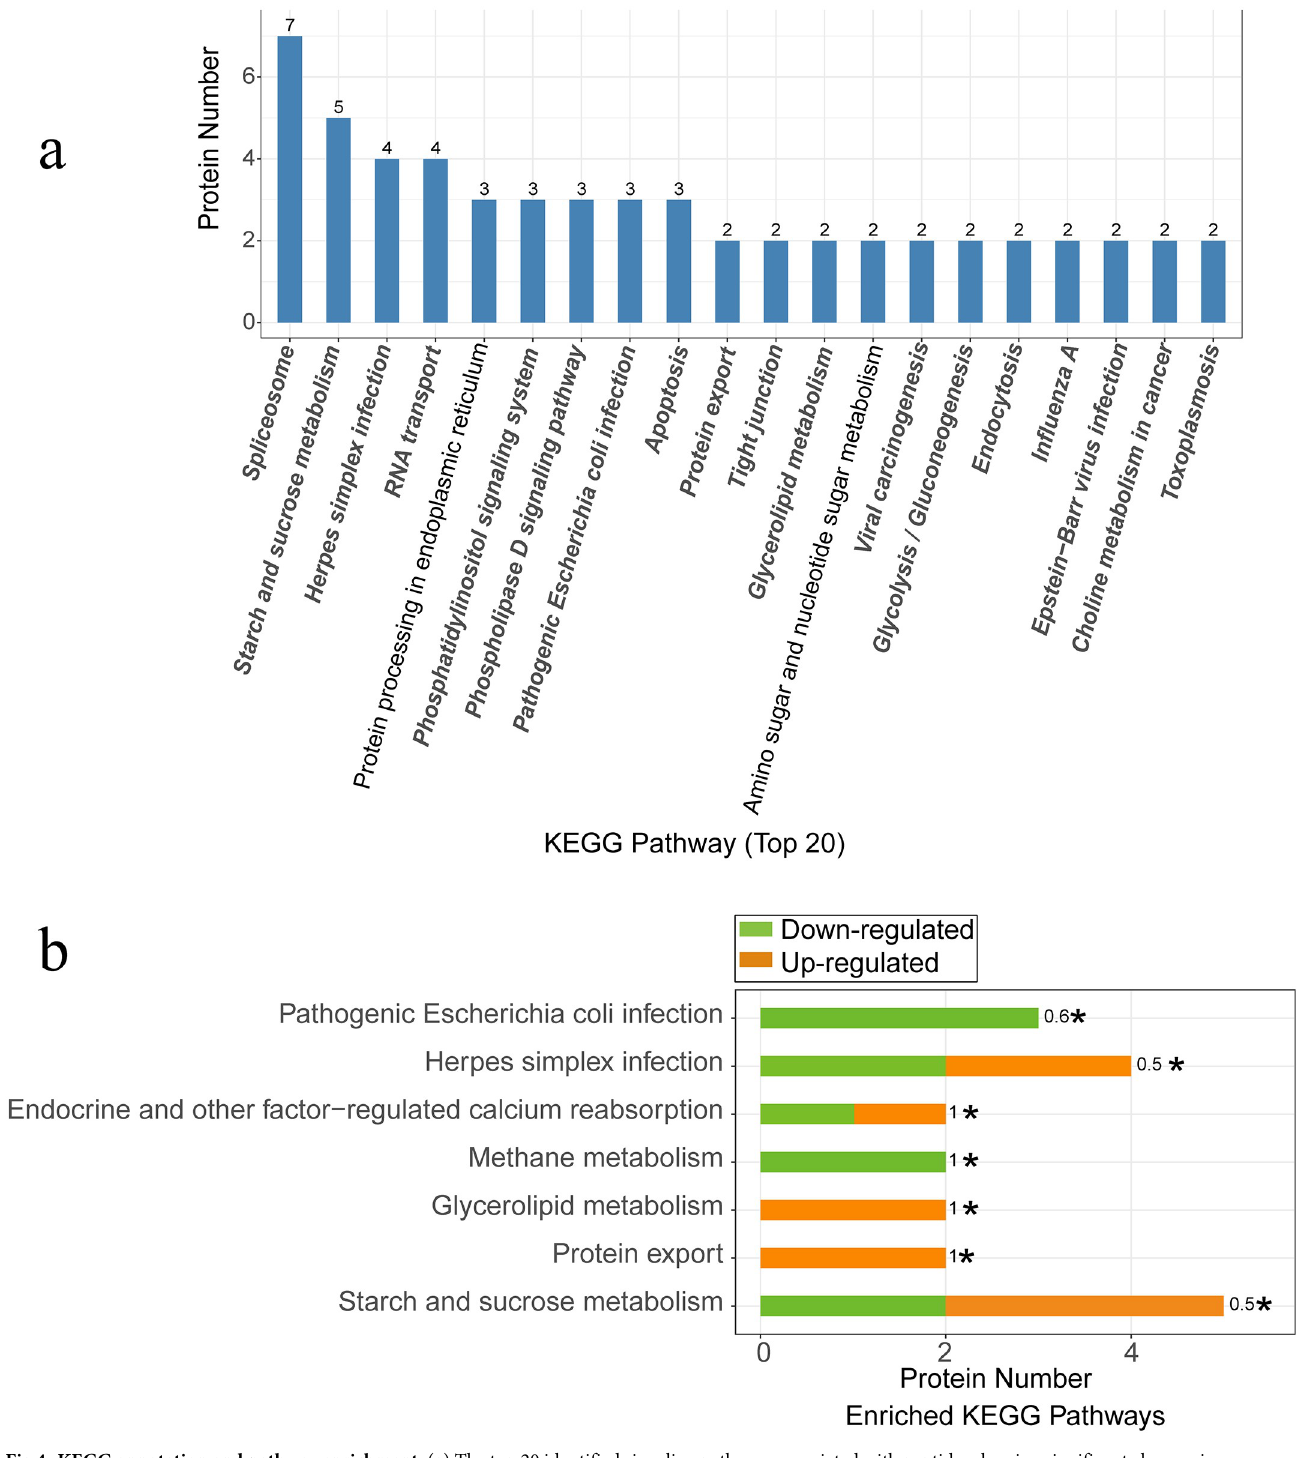
Fig 4. KEGG annotation and pathway enrichment. ( a ) The top 20 identified signaling pathways associated with peptides showing significant changes in abundance. ( b ) Phosphoprotein activity associated with metabolism under high-temperature treatment determined by Fisher’s exact test.